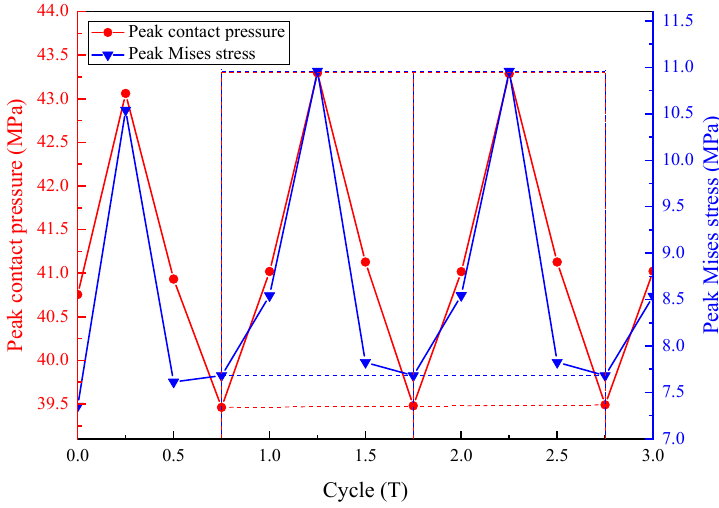
Figure 7. The peak contact pressure and peak Mises stress changes during 0–3 T ( A f = 0.2 mm). Additionally, Figure 8 reflects the change in the peak stress of the X-ring during 0–3 T when A f is 1.2 mm. At 0.5 T, the peak stress of the X-ring begins to change periodically with a period of 1 T. During each fretting period, taking 0.5–1.5 T as an example, the peak stress of 0.5 T is equal to 0.75 T. During 0.75–1 T, the peak stress increases significantly. The peak stress of 1.25 T equals that of 1 T. During 1.25–1.5 T, the peak stress decreases substantially. Eventually, the peak stress of 1.5 T equals the peak stress of 0.5 T. These rules are entirely consistent with the peak Mises stress variation rule in Section 4.1. In conclusion, when the A f increases from 0 mm to 2 mm, the fretting of the X-ring runs in the sticking region, the mixed slip region, and the gross slip region successively. The critical fretting displacements into the mixed slip region and the gross slip region for the inward and outward strokes are all the same, 0.4 mm and 1.2 mm, respectively. The larger the A f is within a specific range, the earlier the X-ring enters the fretting cycle. The fretting period of the X-ring is not affected by the A f and always remains 1